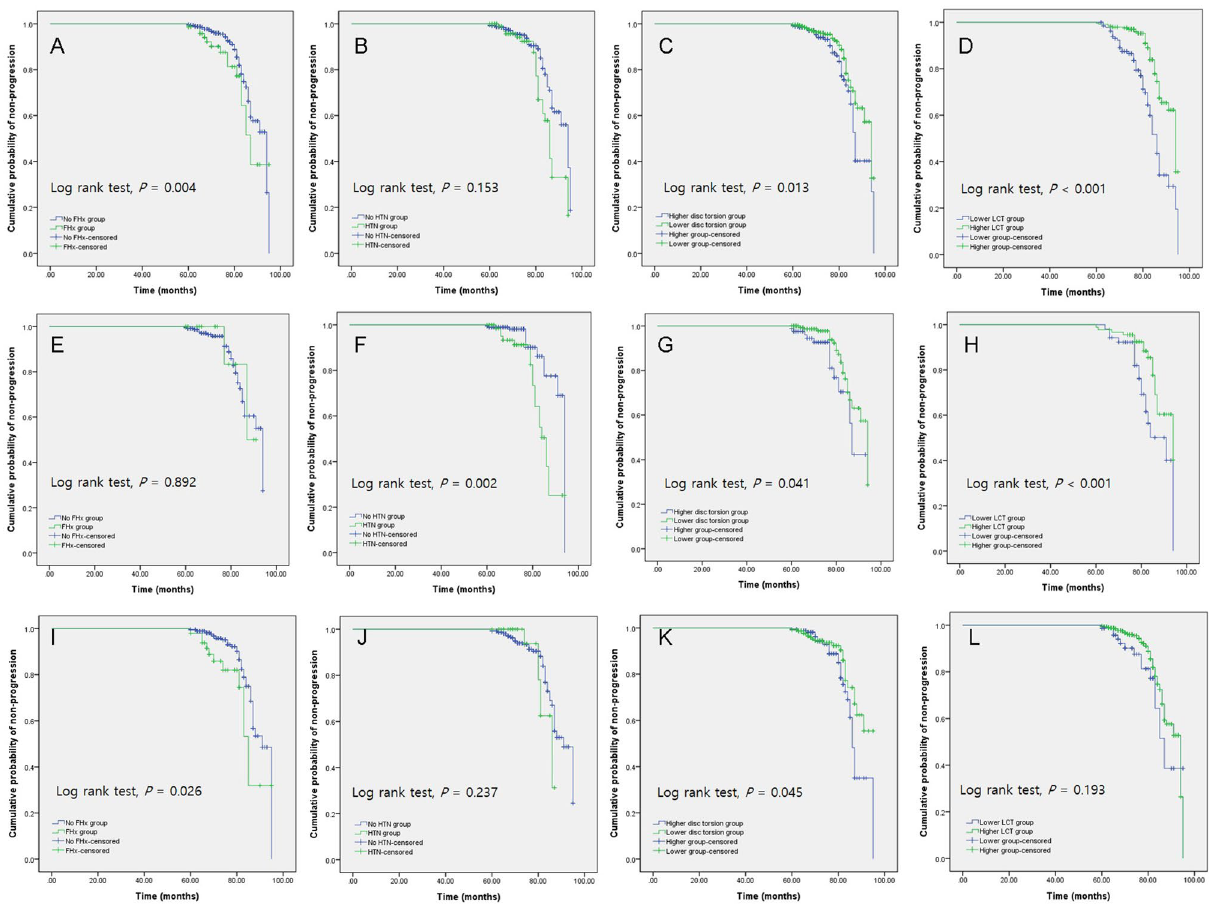
Figure 1. Kaplan–Meier survival analysis of normal-tension glaucoma (NTG) conversion in NTG suspects according to family history of glaucoma ( A , E , I ); medication for systemic hypertension (HTN) ( B , F , J ); direction of disc torsion ( C , G , K ); lamina cribrosa thickness measured on spectral-domain optical coherence tomography scans, classified according to a cut-off value of 180.5 μm (calculated based on the data of the present cohort) ( D , H , L ). ( A – D ), all NTG suspects; ( E – H ), NTG suspects without myopia; ( I – L ), NTG suspects with